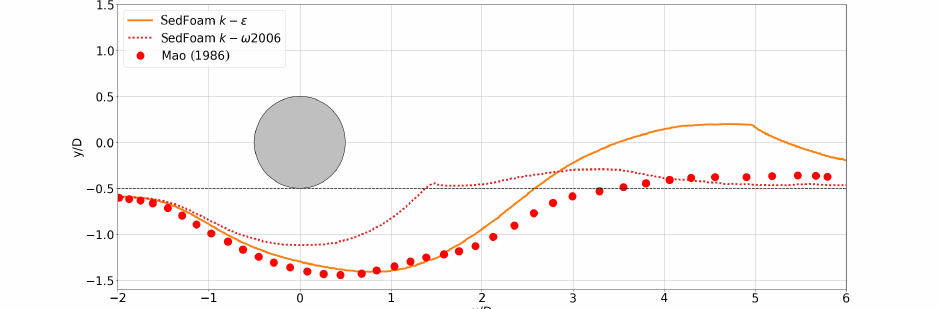
Figure 5. Bed profiles at 25 s from simulations with the µ ( I ) rheology using the k − ε (orange line) and k − ω 2006 (red dotted line) turbulence models compared with the experimental data from Mao (1986) [2] (red